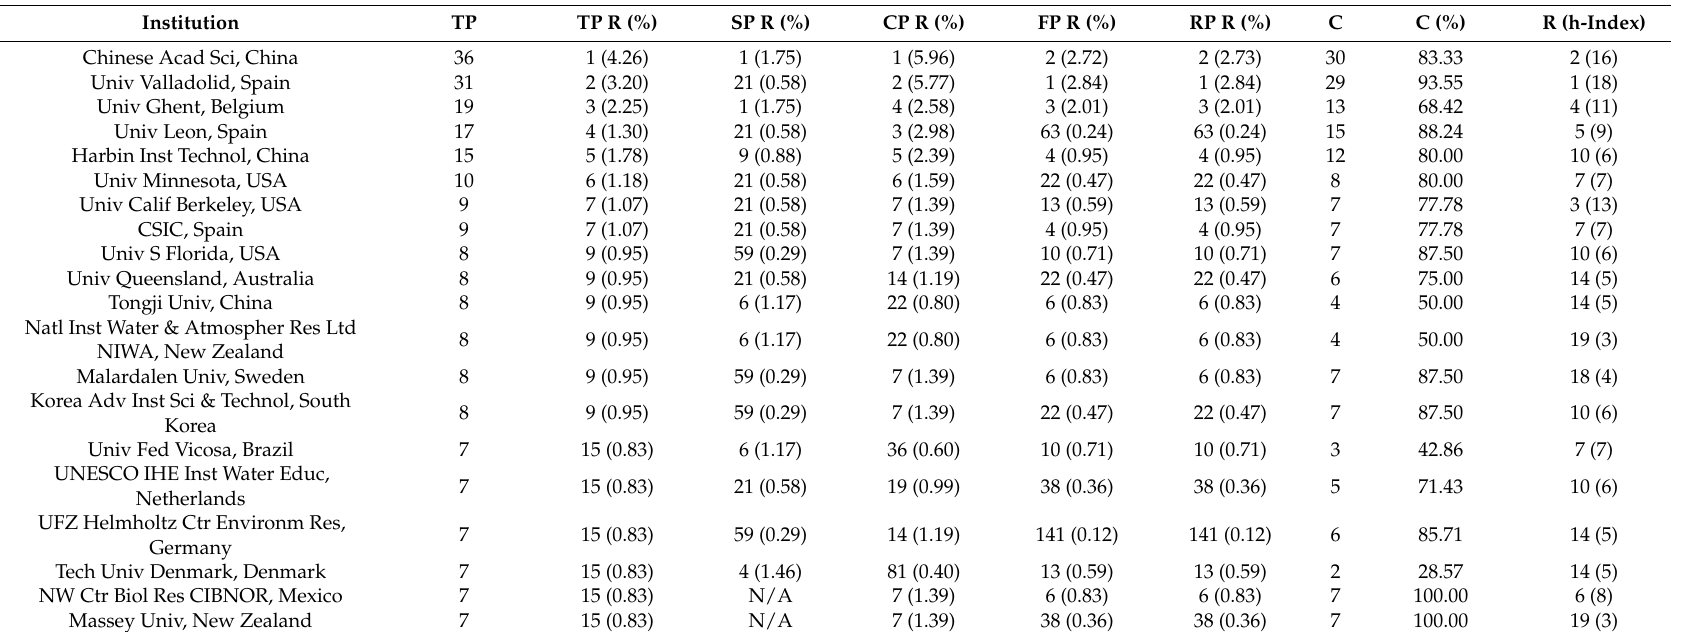
Table 5. Top 20 productive institutions during